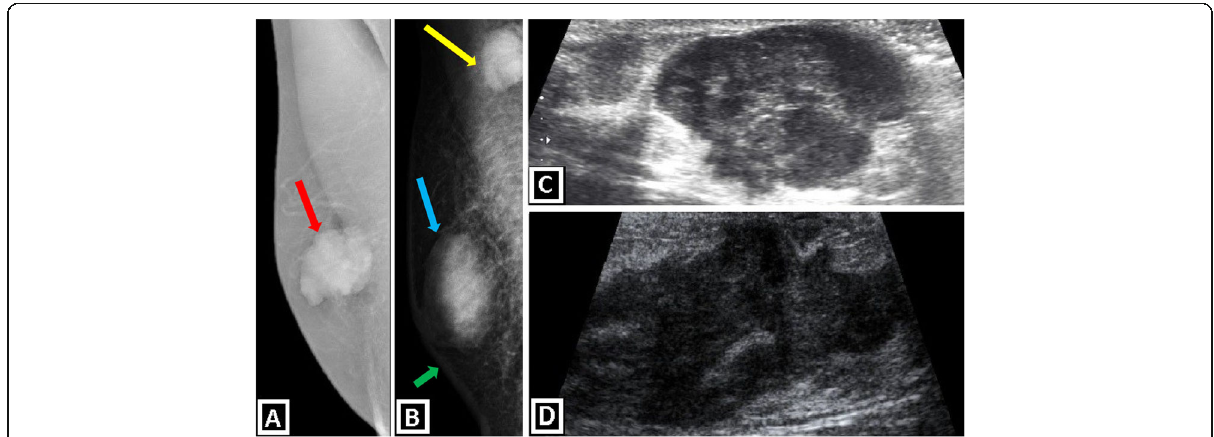
Fig. 11 Mammography and US images show primary male breast cancer. a , b Medio-lateral oblique mammograms show invasive ductal carcinoma of the breast. Lobulated subareolar masses with high density, without microcalcification are seen (red and blue arrows). a Grade 2 invasive ductal carcinoma. b Grade 3 invasive ductal carcinoma with axillary lymph node metastasis (yellow arrow) and skin thickening (green arrow). US images of grade 2 ( c ) and grade 3 ( d ) invasive ductal carcinomas reveal irregular shape and indistinct margins of the